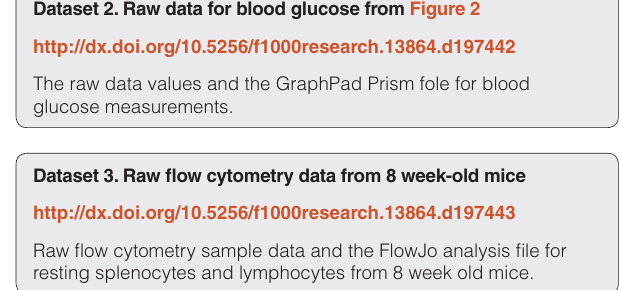
Dataset 3. Raw flow cytometry data from 8 week-old mice http://dx.doi.org/10.5256/f1000research.13864.d197443 Raw flow cytometry sample data and the FlowJo analysis file for resting splenocytes and lymphocytes from 8 week old mice.